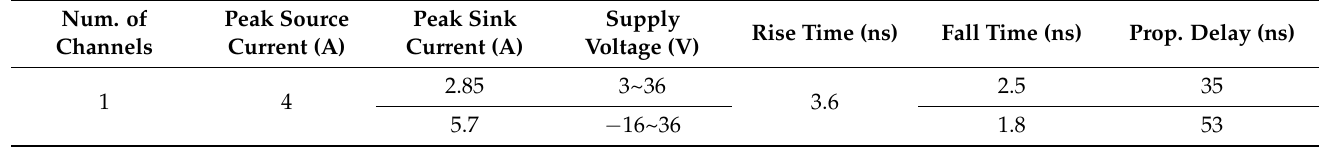
Table 32. Commercial SiC MOSFET drivers by Maxim Integrated.